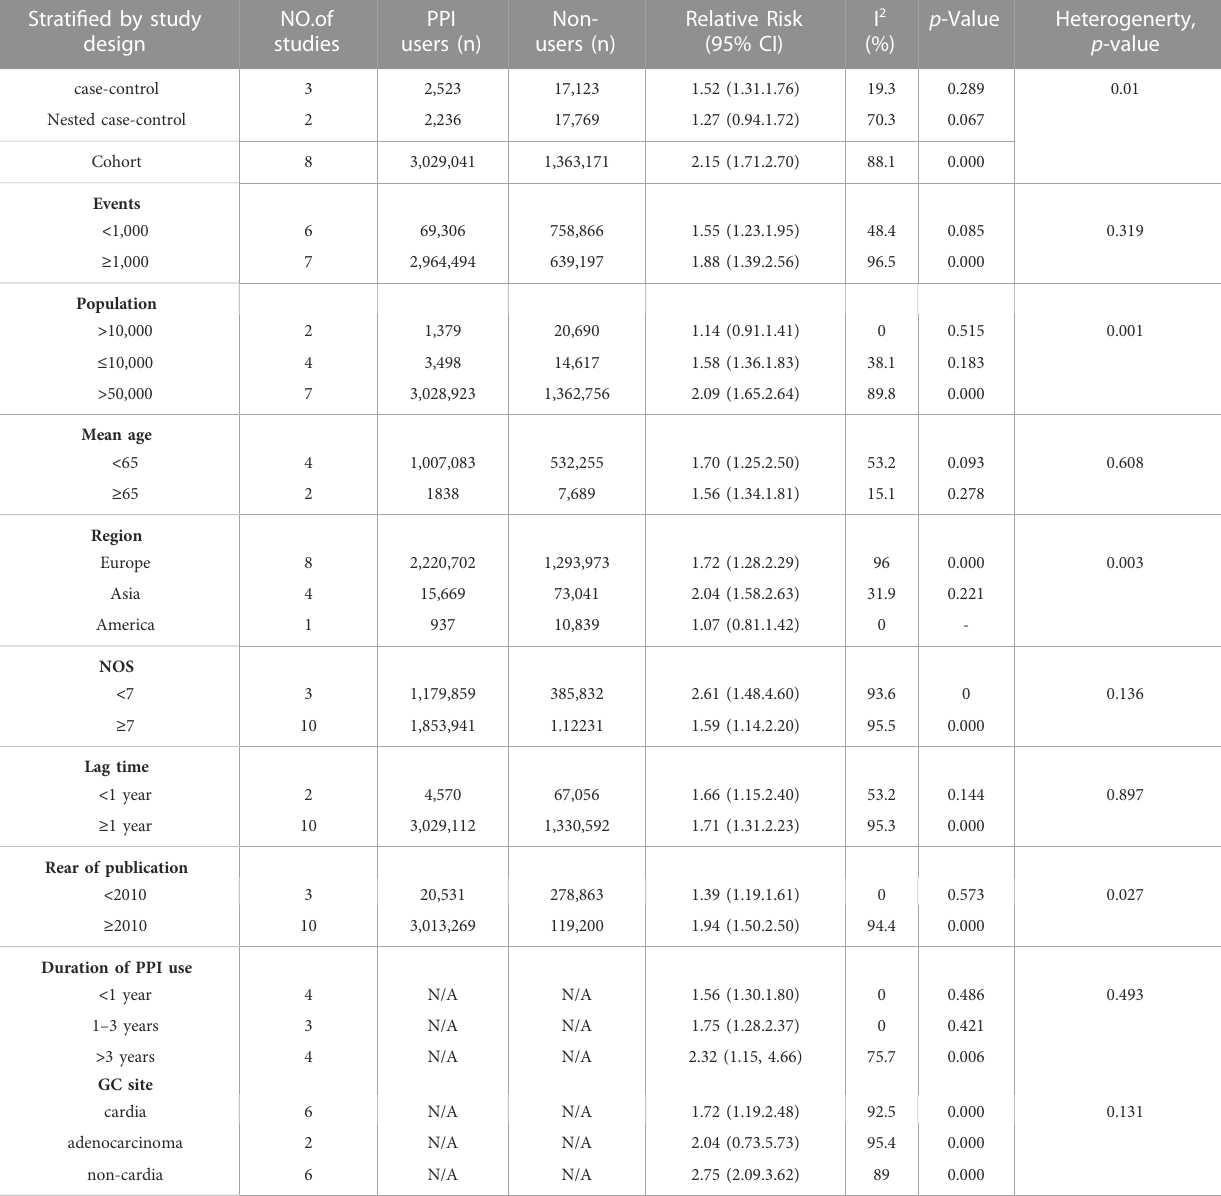
TABLE 3 Subgroup analysis of Proton Pump Inhibitor Use and the Risk of Gastric